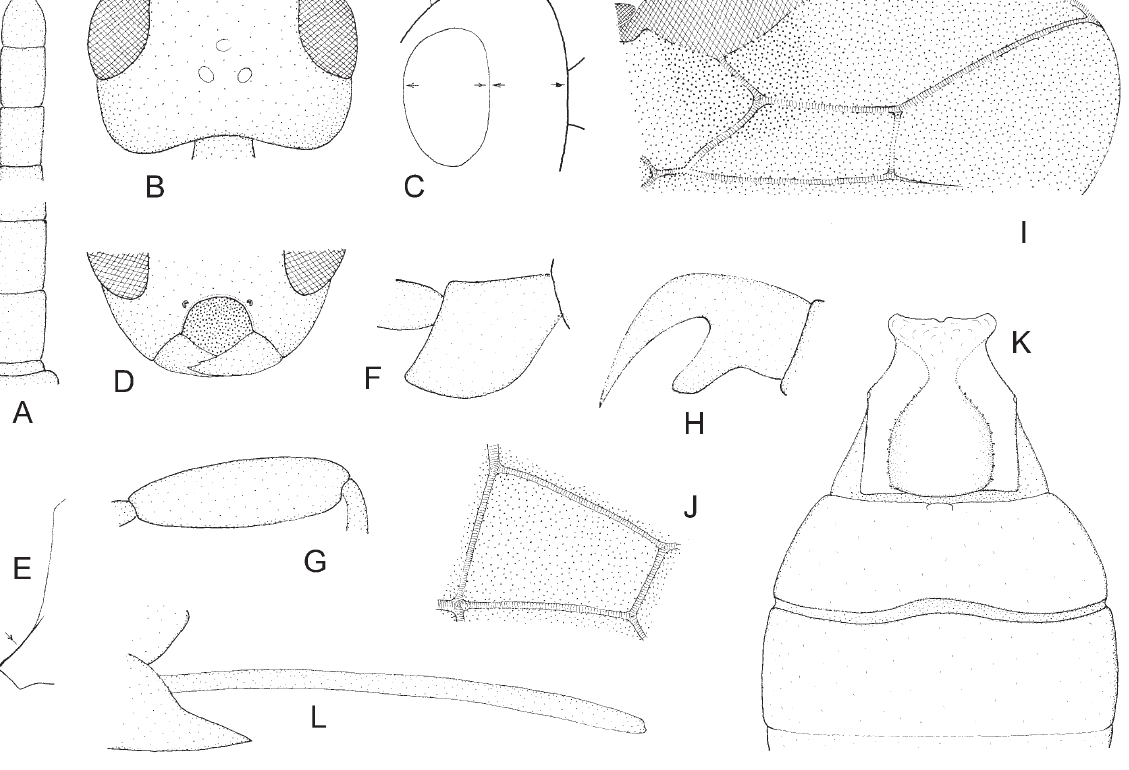
Fig. 40. Bracon ( Pigeria ) piger Wesmael, 1838, ♀ lectotype. A . Flagellomeres 1-2 and 30-32. B . Head in dorsal view. C . Head in lateral view. D . Head in frontal view. E . Propleura in lateral view. F . Fore coxa in lateral view. G . Hind femur. H . Claw. I . Distal part of right forewing. J . First discal cell of right forewing. K . Tergites 1-3. L . Hypopygium and ovipositor